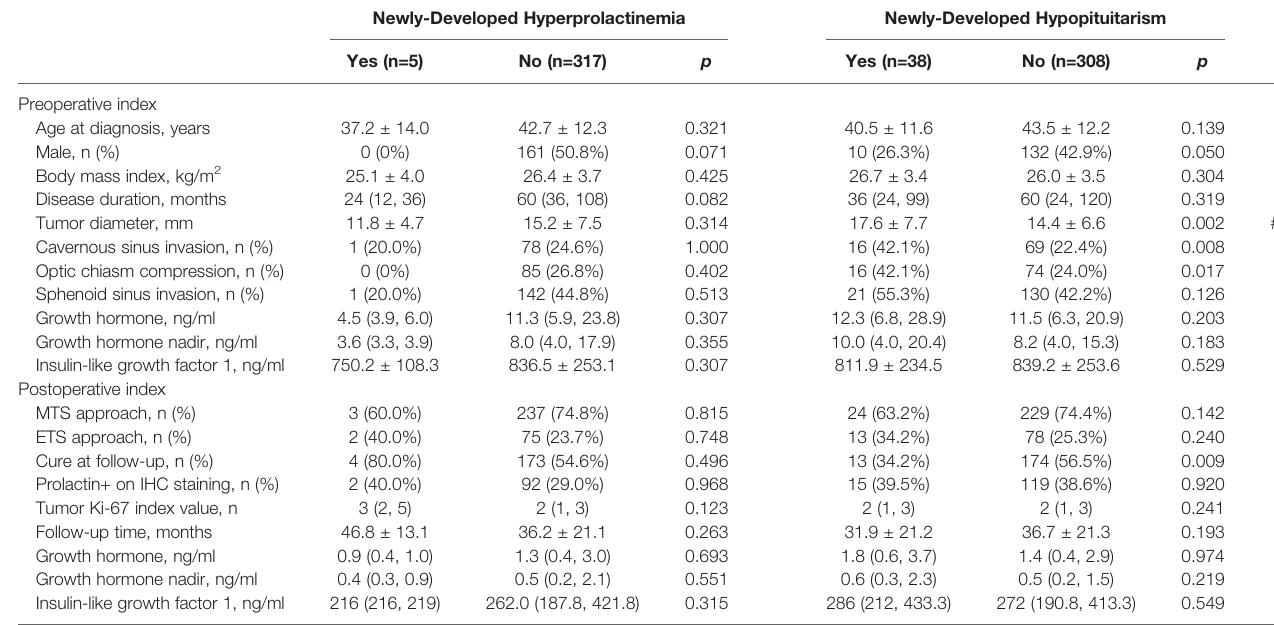
TABLE 4 | Risk factors of newly-developed hyperprolactinemia and hypopituitarism after